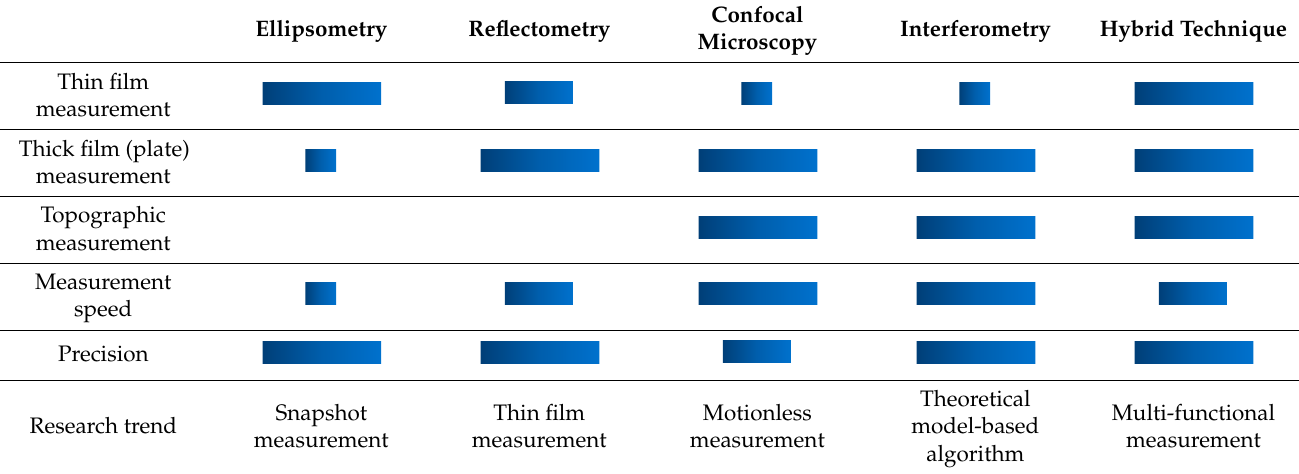
Table 1. Summary of the comparison between film measurement techniques.